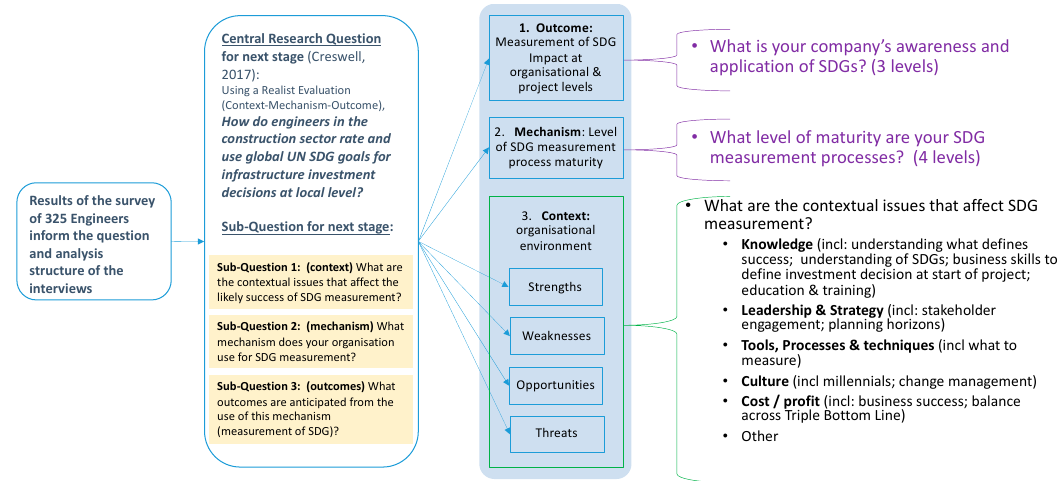
Figure 16. Proposed nodal evaluation framework for sequential explanatory design of the next stage—the semi-structured interviews of forty executives.